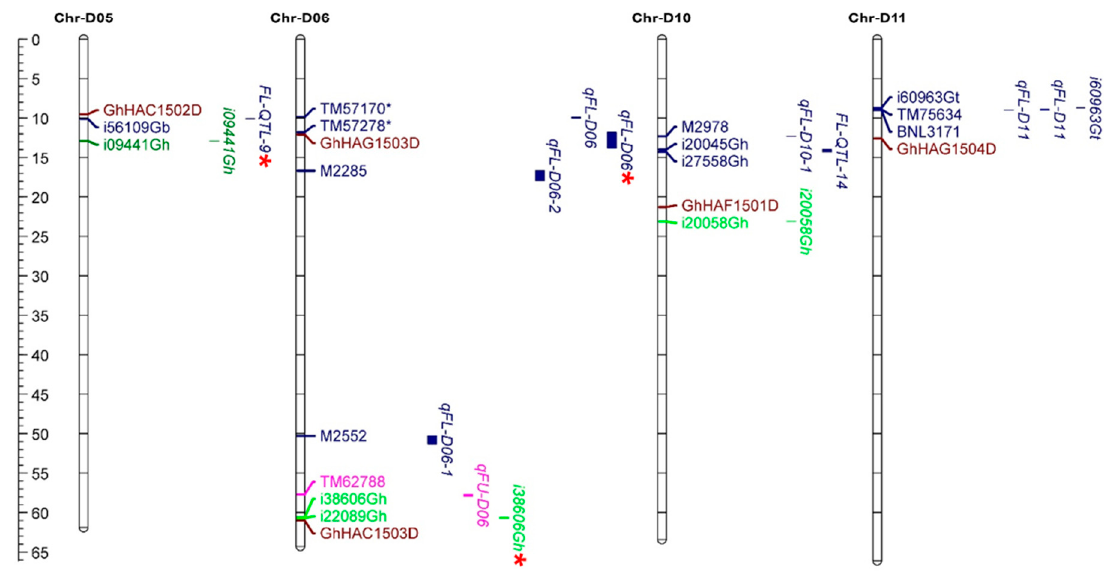
Figure 7. Distribution of co-localized HAT genes on chromosomes of A and D subgenomes of G. hirsutum . The scale represents the physical position of genes and quantitative trait loci (QTL)-linked markers in megabases (Mb). QTLs / Single Nucleotide Polymorphism (SNPs) related to fiber length (FL), fiber elongation (FE), fiber micronaire (FM), fiber strength (FS), and fiber uniformity (FU) are shown. Asterisks indicate that the HAT genes co-localized with QTLs / SNPs related to fiber.